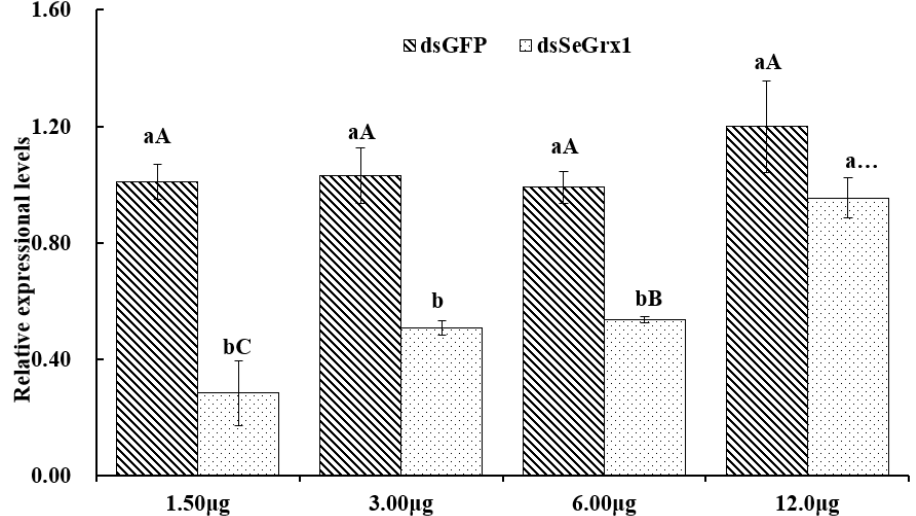
Figure 4. The relative expression of SeGrx1 after RNAi in the larvae of S. exigua . Data are presented as mean ± standard error. Independent samples t-test and one-way ANOVA, followed by the Duncan’s multiple range test were performed by using SPSS 26.0 Software Package (SPSS Inc., Chicago, IL, USA). Data followed by the same lowercase letters indicate no significant difference at 0.05 level between ds GFP group and ds SeGrx1 treatment at the same time. Data followed by the same capital letters indicate no significant difference at 0.05 level among the same group treated with different concentration of dsRNA.